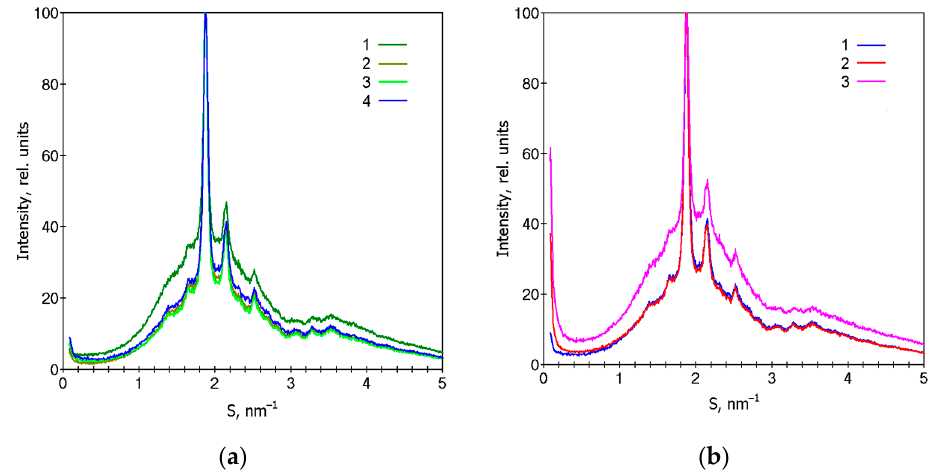
Figure 3. XRD patterns of film samples with the NR content, wt.%: (1) 0, (2) 5, (3) 10, (4) 15, ( a ) and the PLA85/NR15 film after the Sturm experiment: (1) initial, (2) less destroyed region, and (3) more destroyed region ( b ).